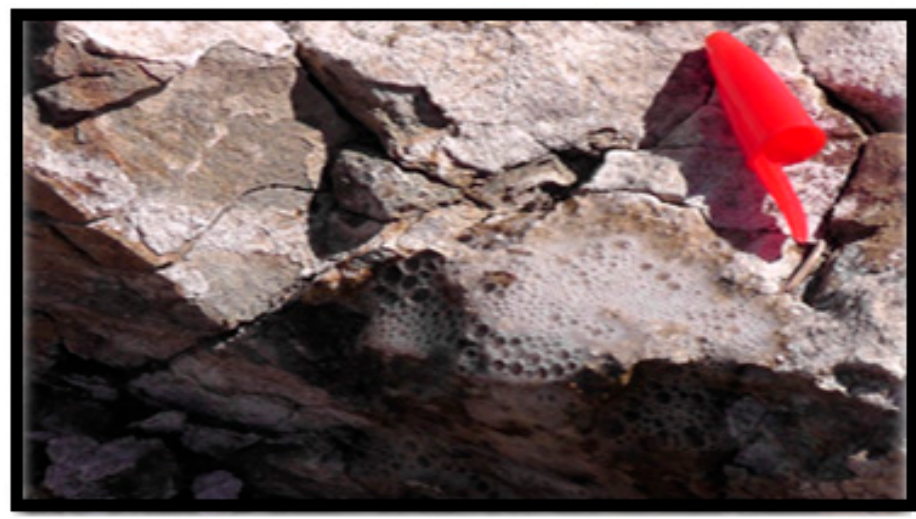
Figure 4. Calcium carbonate precipitated on the dolerite at the eastern flank of the effective water- shed.